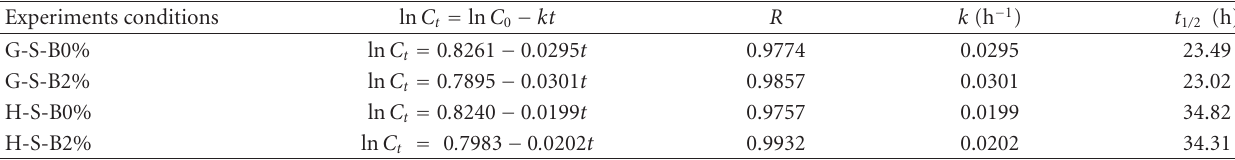
Table 2: Degradation kinetic results of atrazine under visible light irradiation with di ff erent iron